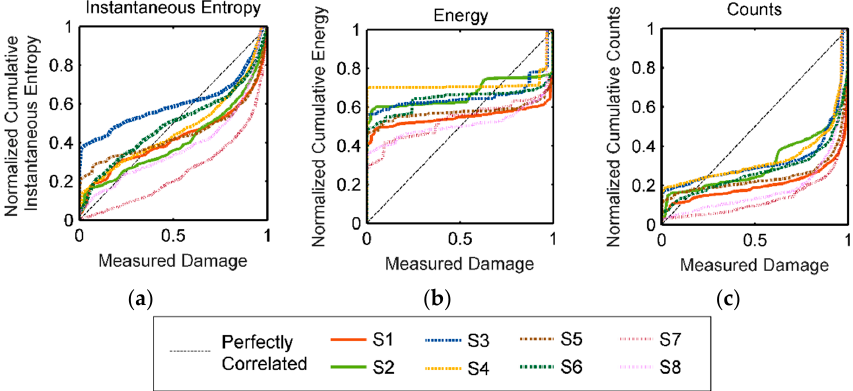
Figure 9. Normalized cumulative trend for three parameters with respect to measured damage or MDD where a one-to-one relationship is desired: ( a ) instantaneous entropy; ( b ) energy; and ( c ) counts. The differences between the cumulative AE parameters damage trends can be quantified by measuring the deviations from the one-to-one ideal relationship. The deviations are measured at each instance of an AE signal. The summation of these deviations, referred to as the deviation factor, can then be used as a goodness of fit metric of the one-to-one model and compared between the AE parameters for each test. The AE parameter with the lowest deviation factor is assumed to be a better representation of damage. It should be noted that only the deviation factors can be compared because all AE features are normalized to the same scale and the number of deviations are equal between parameters for each experiment. The deviation factors for each of the experiments and for each of the cumulative AE parameters were calculated and are plotted in Figure 10. Results show the deviation factor for instantaneous entropy is lower than the deviation factors for counts and energy for all but damage compared to counts and energy.